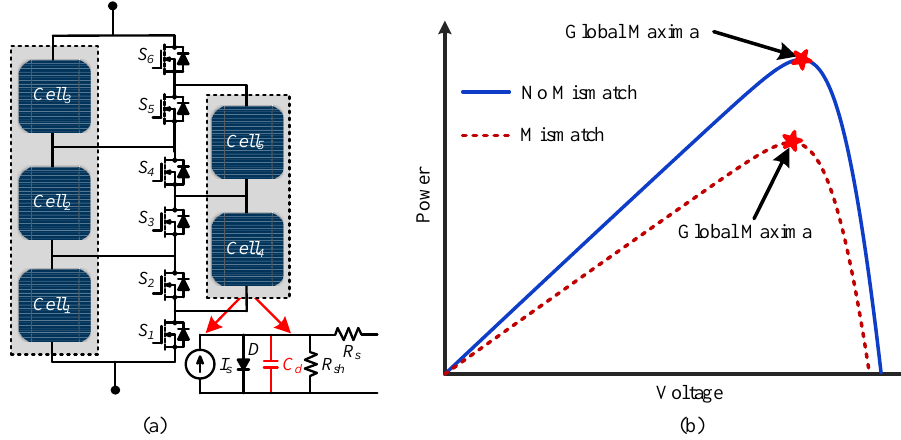
Figure 4. Distributed power electronic (DPE) converters.